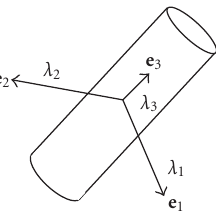
Figure 1: An illustration of a vessel model. It is assumed that the model has a cylindrical shape with a 2D Gaussian-like intensity distribution at each cross section. The arrows show the eigenvectors of a Hessian matrix at the center. The length of the arrows represents the absolute value of corresponding